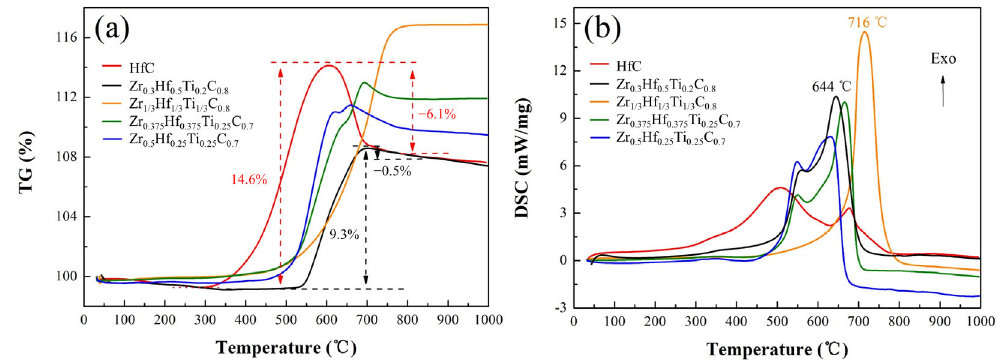
Fig. 5 TG–DSC curves of (Zr,Hf,Ti)C x carbides and commercial HfC: (a) TG and (b) DSC.